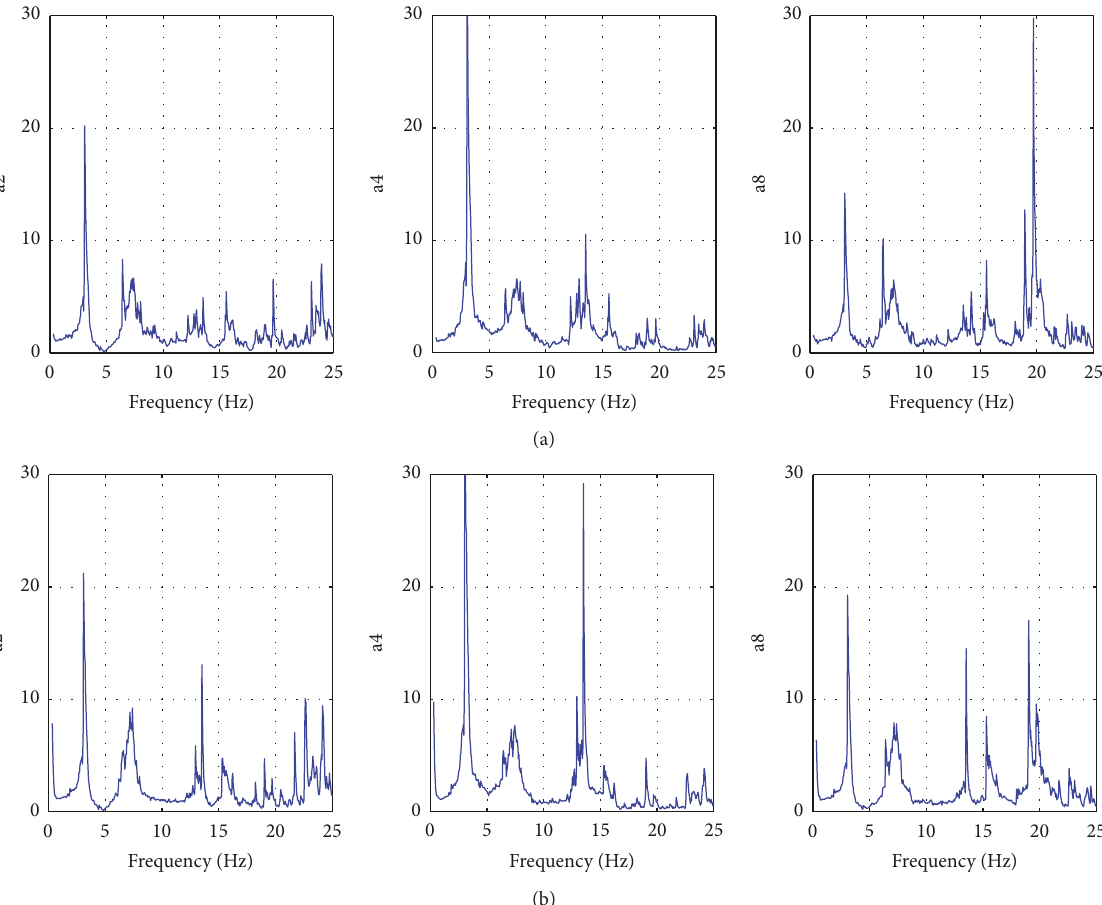
Figure8:Passiveconnected(PC)configuration,experimentalpseudofrequencyresponsefunctions.Groundacceleration 𝑥 direction,voltage level (a) 1V and (b) 2.5 V. El Centro test PGA 0.6